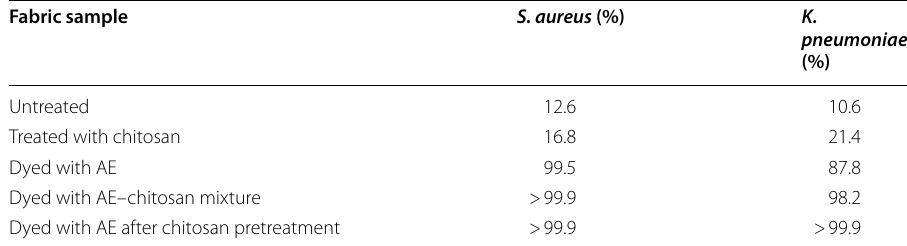
AE Aronia berries extract